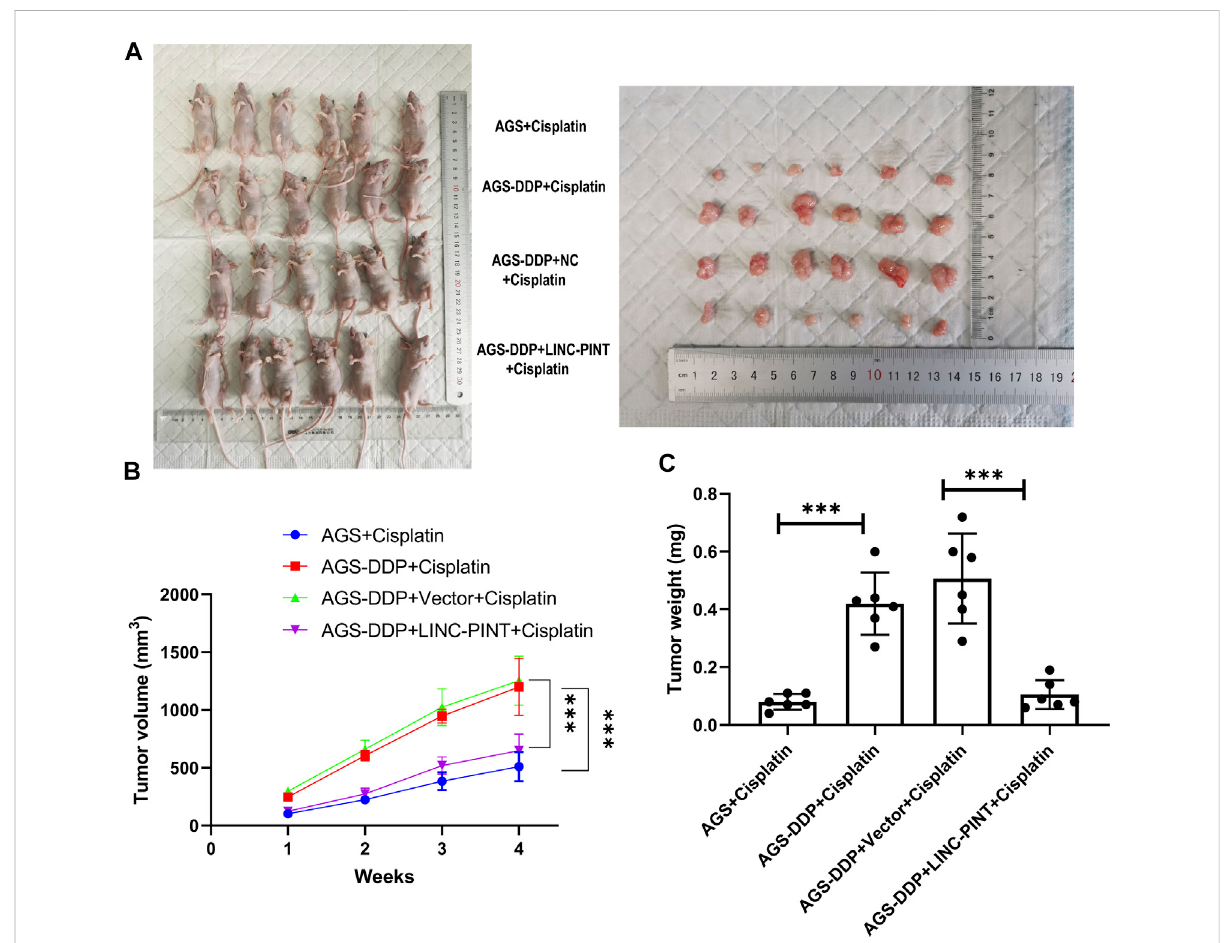
FIGURE 7 Effect of LINC-PINT on tumor development in vivo . (A) The nude mouse model of LINC-PINT-overexpressed DDP-resistant cells and control DDP-resistant cells. (B) Average volume of transplanted tumors from respective groups. Tumor volume was measured every 3 days. (C) Average weight of transplanted tumors from respective groups. Data were represented as the mean ± SD. * p ＜ 0.05. ** p < 0.005. *** p <